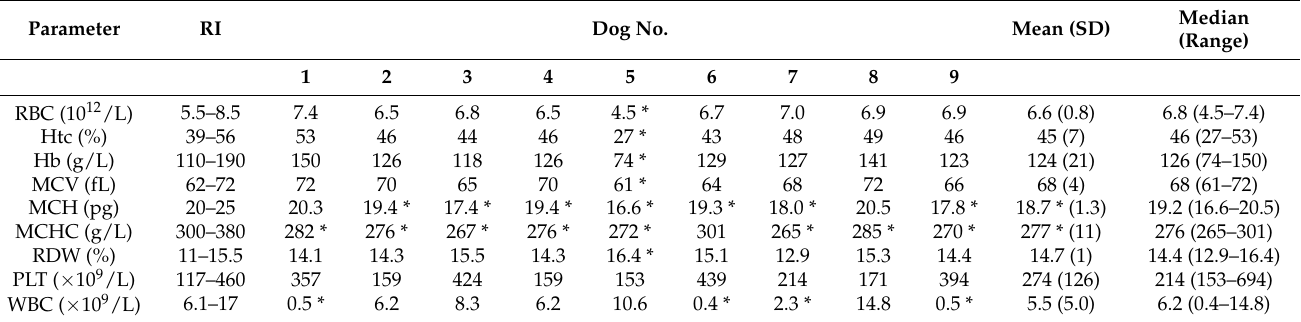
Table 5. The complete blood count results of 9 puppies affected by canine parvovirus